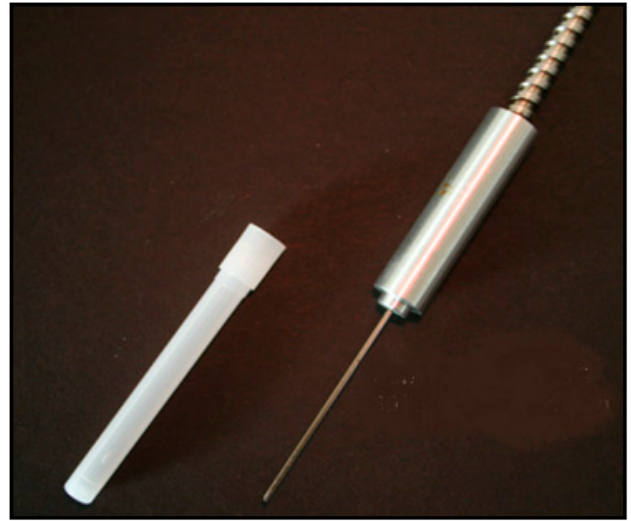
Figure 5. Cannula sterican 19G, 30° bevel [4].